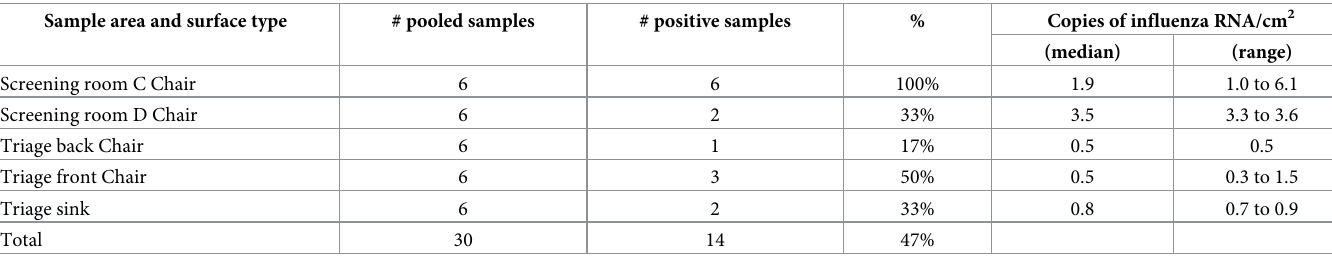
Table 7. Influenza virus detected in surface samples by area where sample was collected and type of surface swabbed. Sample area and surface